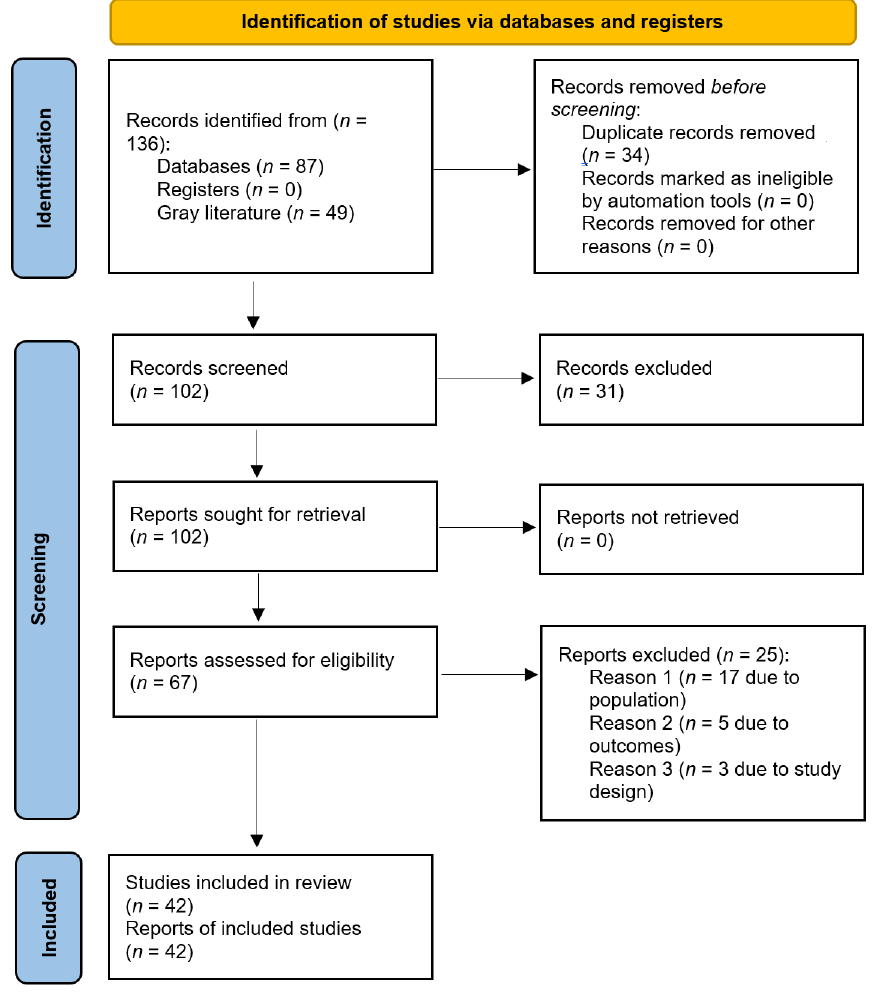
Figure 1. PRISMA flow-chart.